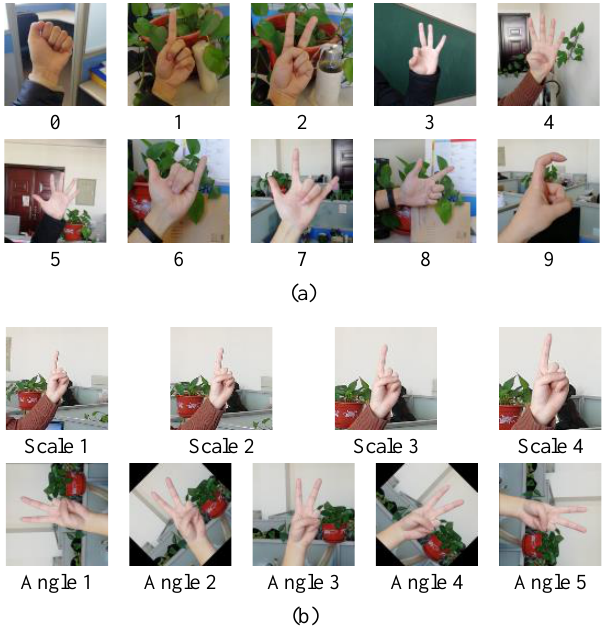
Figure 11. ( a ) 10 kinds of self-collected hand gesture images. ( b ) Gesture images with different scales and